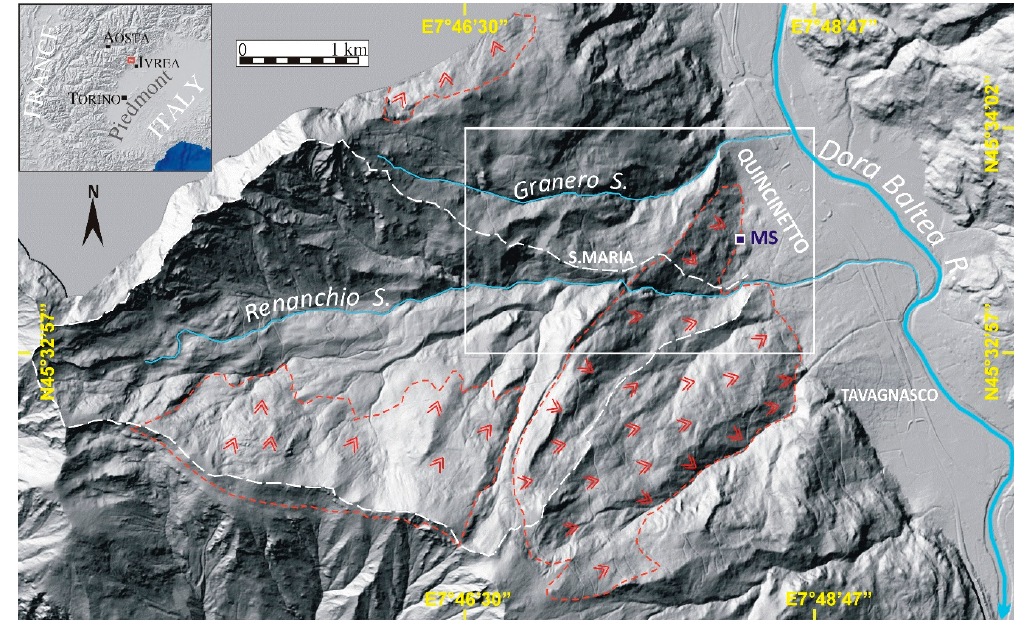
Figure 1. DTM reporting the right slope of Dora Riparia Valley in which the Montellina Spring (MS) is located and the Renanchio Basin. The red arrows represent the DSGSD areas. The white square indicates the investigated area.